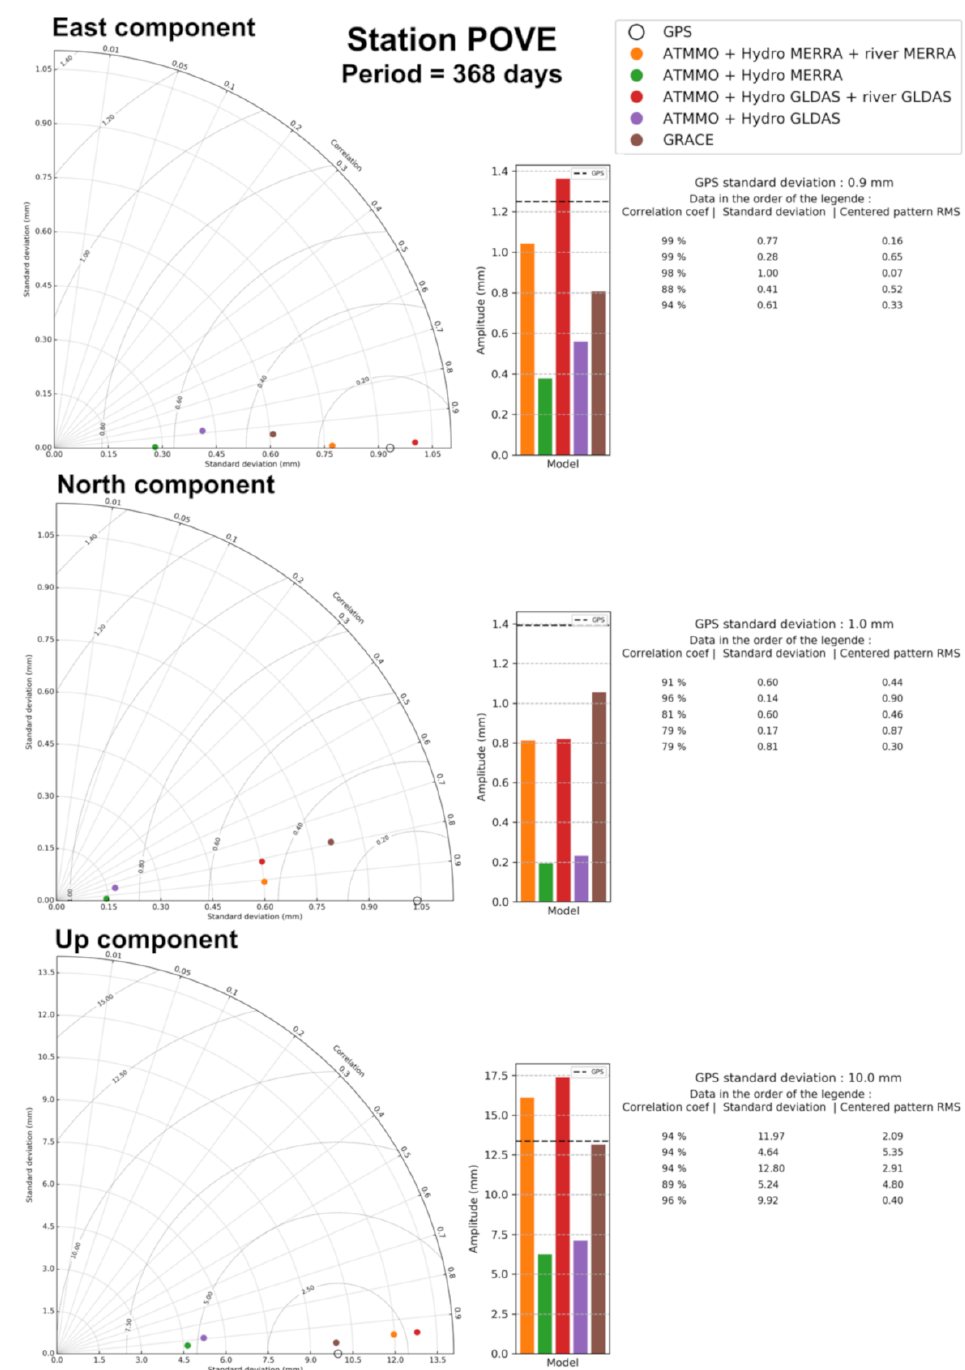
Figure 8. Example of Taylor diagram for the annual term at POVE (Porto Velho, Brazil) for the different loading models using GPS as the reference time series (in black) for the East ( top ), North ( middle ), and Up ( bottom ) components. The full nontidal loading signal is modelled using ATMMO for the atmosphere and the ocean effect combined with the hydrological contribution estimated using the classical MERRA-land model (in green), MERRA-land with the river contribution (in orange), GLDAS/Noah (in purple) or GLDAS/Noah with the river contribution (in red). The brown dot shows the full signal inferred from GRACE solution. The table gives the correlation coefficient (in %), the standard deviation (in mm), and CRMS (in mm) with respect to the GPS for each solution in the same order as the legend. The histogram indicates the amplitude (in mm) for each solution. The horizontal dashed line indicates the value for